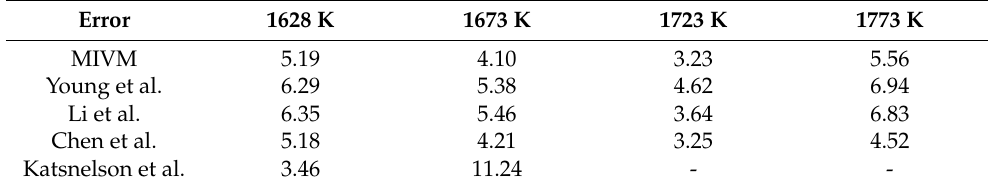
Table 2. Calculated values of B MnC and B CMn using MIVM in Mn-C binary liquid alloys at 1628 K to 1773 K. T(K) B MnC B CMn 1628 2.111 0.969 1673 1.809 1.201 1723 1.780 1.343 1773 1.679 1.703 Table 3. Error comparison between experimental data in previous work and predicted values using different models for the pair potential interaction parameters in Mn-C liquid alloys at 1628 K to 1773 K (%). Error 1628 K 1673 K 1723 K 1773 K MIVM Young et al. Chen et al. Katsnelson et al.